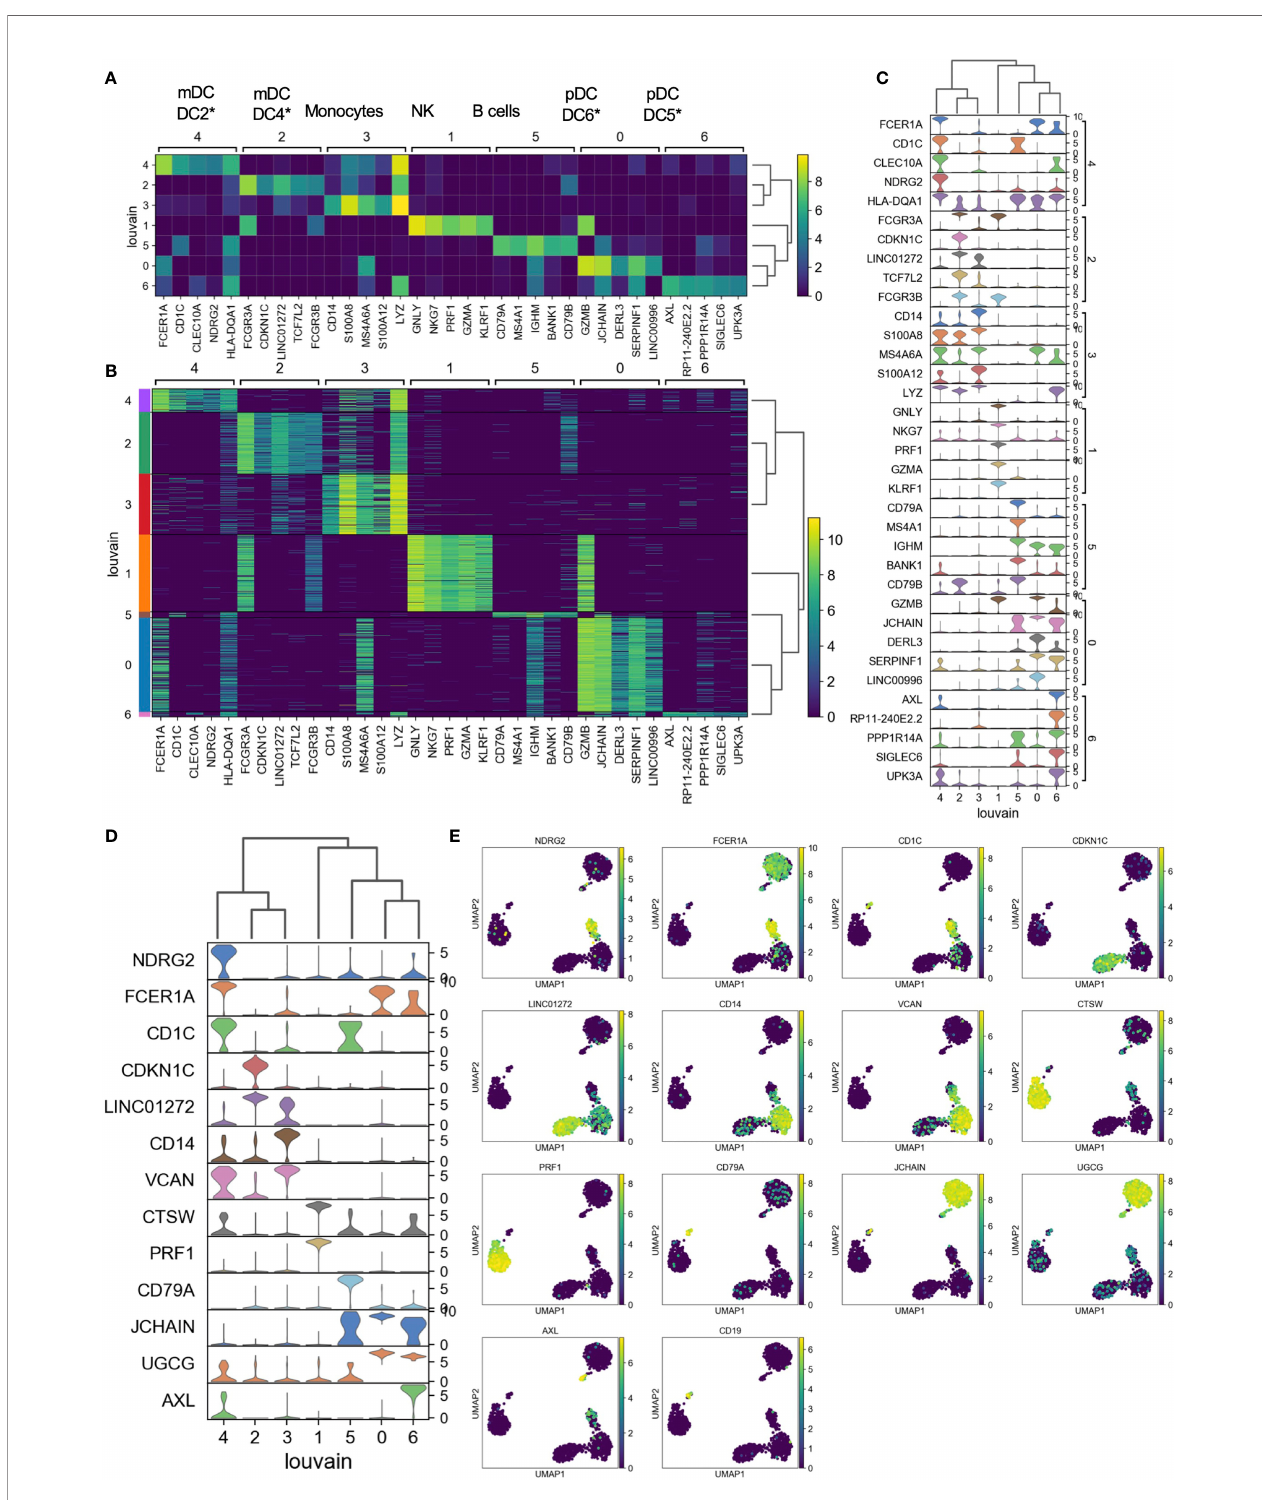
FIGURE 3 | Expression cluster marker genes – (A) The top fi ve marker genes for each cluster was determined by logistic regression. Median expression of marker genes in cells within each cluster is shown. *Dendritic cell types reported in Villani et al. (37) were identi fi ed based on marker gene expression. (B) Expression of logistic regression marker genes in each individual cell within each cluster. (C) Violin plots showing logistic regression marker gene expression distributions. (D) Violin plots showing gene expression distributions for the minimum set of necessary and suf fi cient marker genes as determined using the NS-Forest algorithm. (E) Expression of NS-Forest marker genes in UMAP Louvain